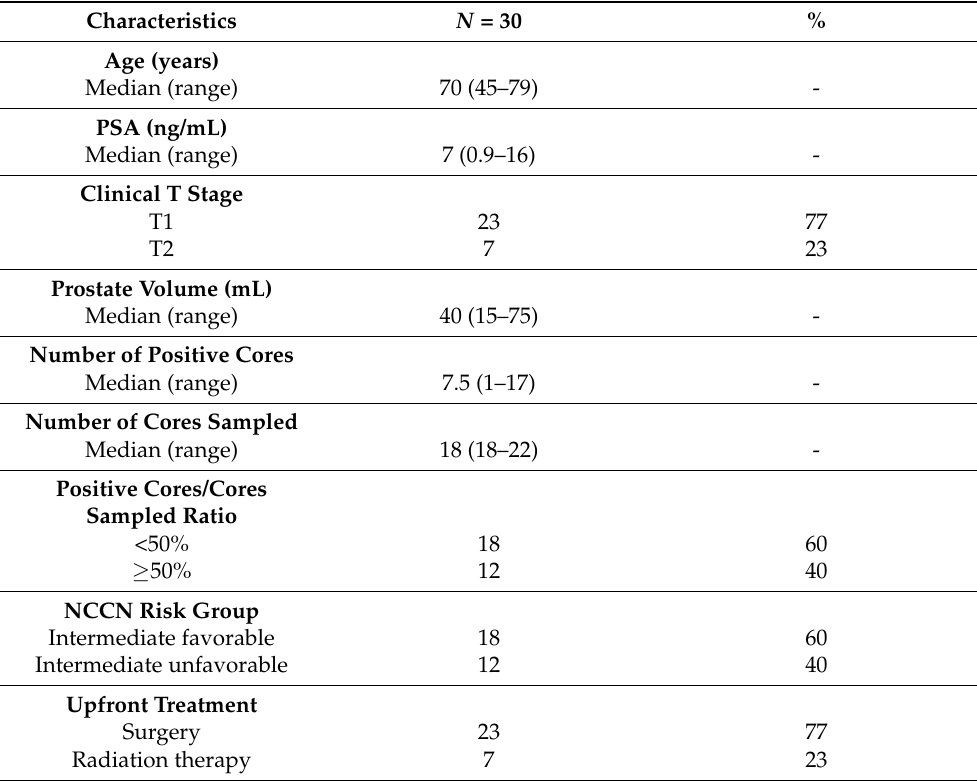
Table 1. Patients’